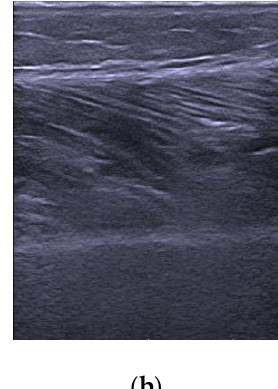
Table 1. Physical, nutritional and muscle ultrasound characteristics.